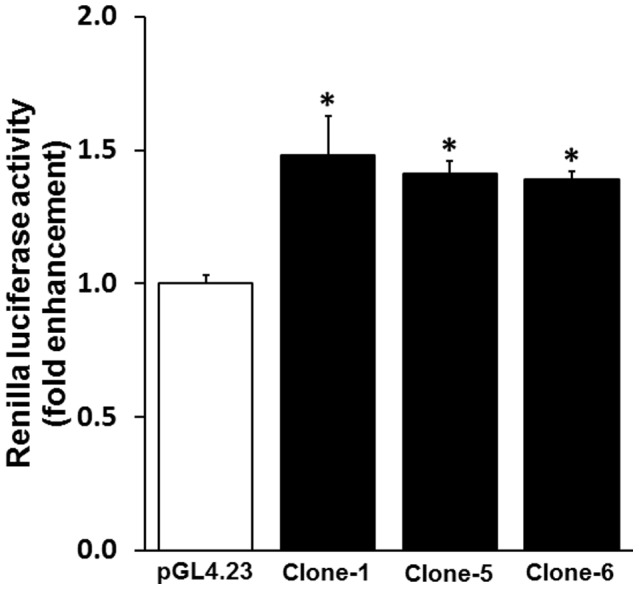
Functional activity of clone-1, clone-5 and clone-6 expressed in CaCo2 cells.The CaCo-2 cells were transfected with either a vector (pGL4.23), clone-1, clone-5, or clone-6. After the transfection, the luciferase activity was measured in the presence and absence of aldosterone (10 nM) treatment. Relative luciferase activity was normalized to the luciferase activity present in the vector transfected cell (pGL4.23; considered 1.0). Data presented represent mean ± SE, from triplicate assays from 3 different experiments). *p<0.05– compared to pGL4.23.